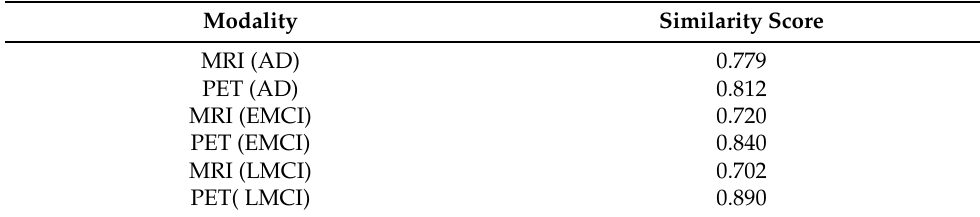
Table 1. Similarity score of original MRI and PET images.